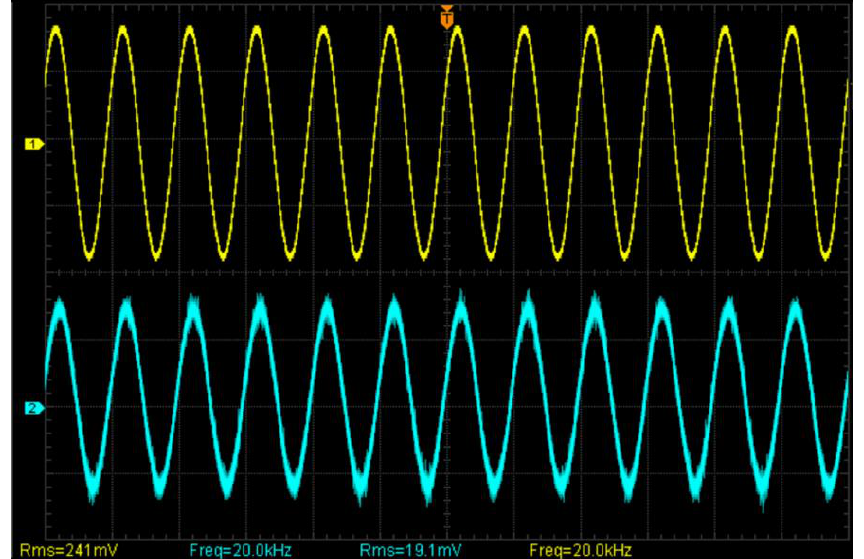
Figure 4. Time-domain comparison measurement results at 20 kHz.